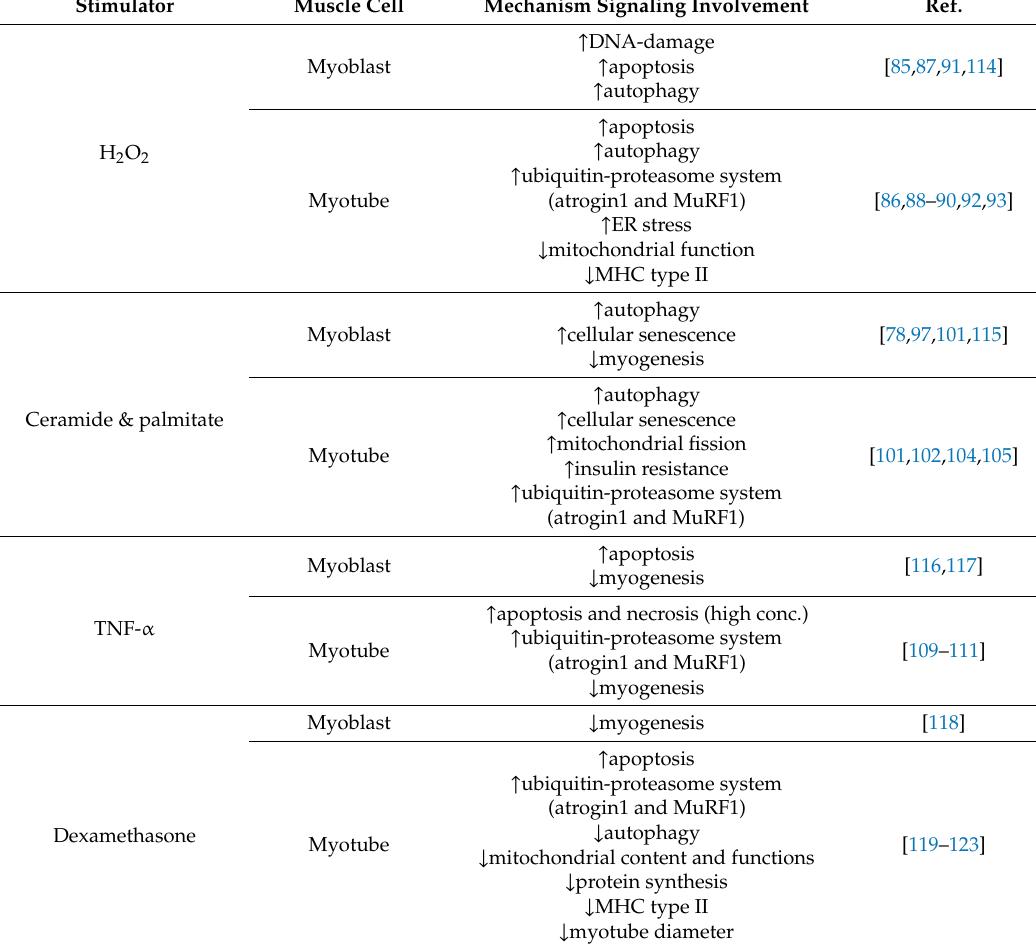
Table 1. In vitro models for mimicking sarcopenia based on aging-associated